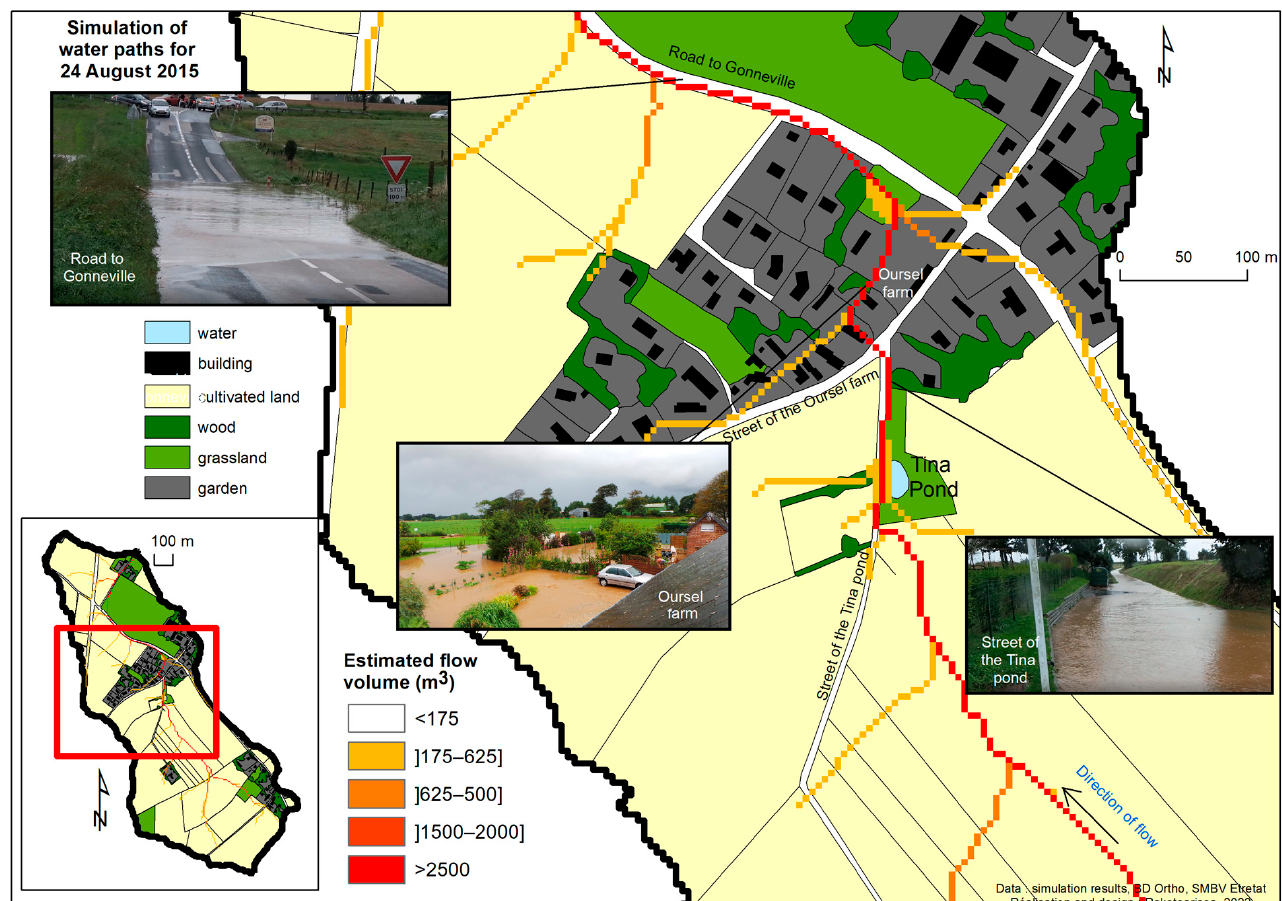
Figure 9. Simulation of water paths for the 24 August 2015 episode from the MAS model. The flood originated on the cultivated plots upstream from the pond called “Tina Pond” (Figure 9). The flow followed the street of Tina Pond before joining the street of Oursel farm (where it was reinforced by meeting the flow coming from the latter). As the topography becomes a little higher as it follows the road, the runoff left the road by branching off and passing through the dwellings (in particular, the B and B and “Oursel farm”). Thereafter, the runoff emerged beyond the dwellings to reach the road to Gonneville. This is where it was reinforced by the inflow from another plot and ended by completely flooding the road, preventing